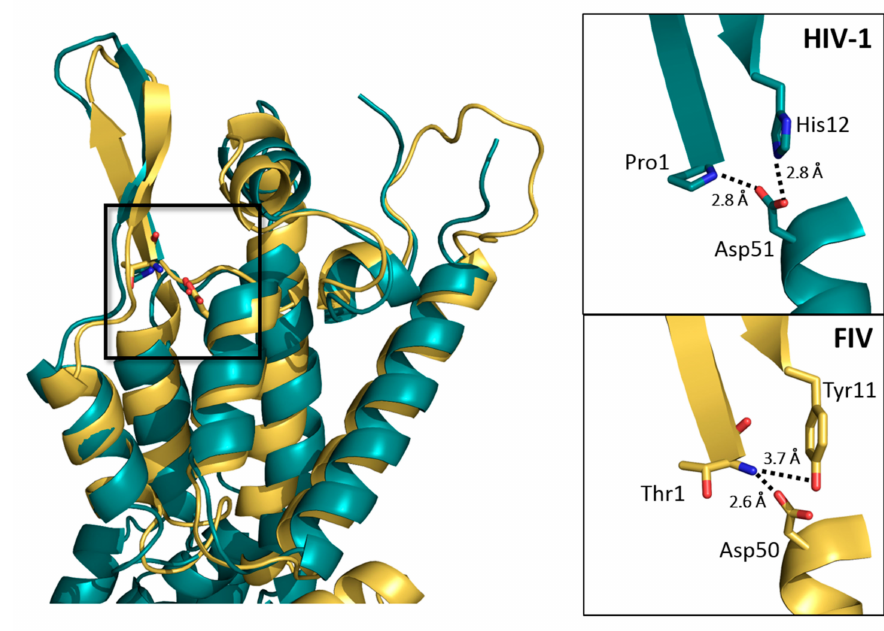
Figure 5. Details of the N-terminal β -hairpin of FIV CA. Superposition of FIV CA NTD (yellow) and HIV-1 CA NTD in its “open” conformation (teal, PDB ID: 5HGL [26]). A detailed view of the boxed region (right) shows the salt bridges of HIV-1 Pro1 and His12 with Asp51 (top) and FIV Thr1 with Asp50 and Tyr11